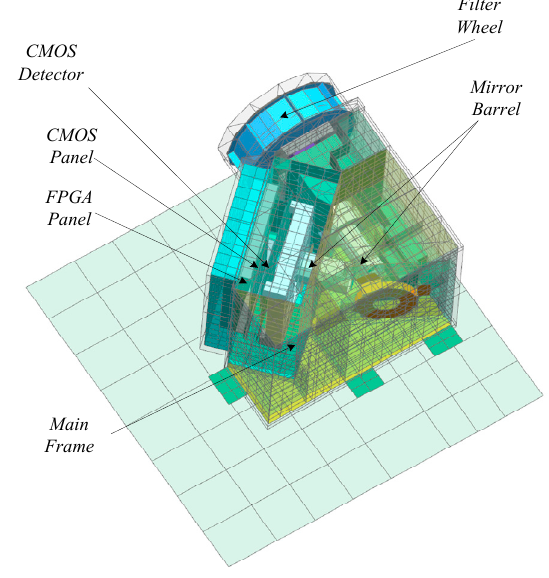
Figure 3. Finite element model of the ADST.